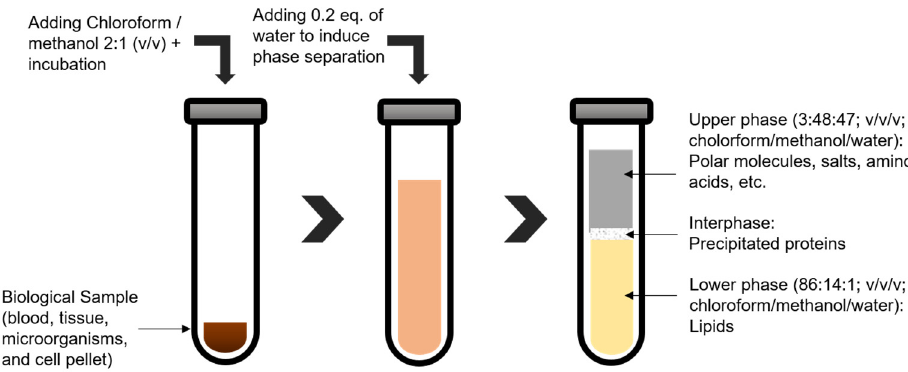
Figure 6. Workflow according to the Folch’s extraction method [42].